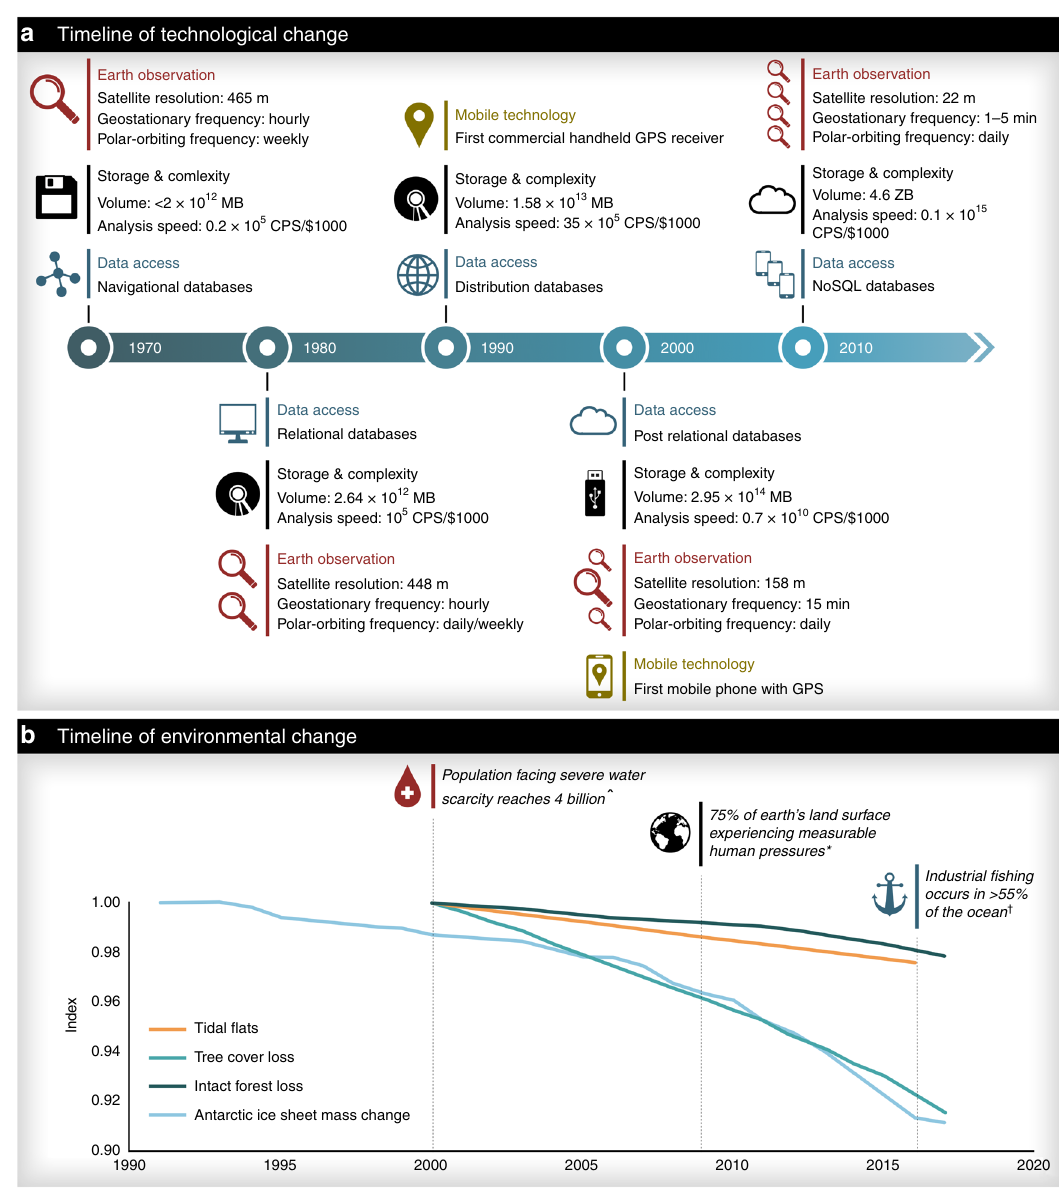
Fig. 1 Timeline of selected technological and environmental changes. ( a ) The volume of data produced has grown exponentially and is expected to soon reach 40 Zettabytes (40 trillion Gigabytes). Such data generation is only possible due to the concurrent growth in data storage and computing speed, which has moved from the fl oppy disk (~1 calculations per second per $1000) to cloud-based storage (>10 15 calculations) in last 30 years 1 . Despite this exponential growth in technological capacity, and increasing environmental applications, our planet is still facing serious environmental declines ( b ). All environmental declines shown are sourced from prior studies (as detailed below) and are indexed relative to their state in the fi rst year plotted (i.e., dividing by the fi rst value in each time series), with the exception of Antarctic ice sheet mass change 2 , which was indexed against expected (BAU) loss by 2100 (81 cm sea-level rise equivalent 3 ). Tidal fl ats represent the overall decline across the globe for time period, and does not show annual fl uctuations 4 . Intact Forest Landscapes and tree cover loss does not take into account gains 5,6 . Note the index on the y -axis is only shown for the range 0.9 – 1. Ɨ Data from Global fi shing watch 7 . *Based on the global human footprint 8 . ^For at least 1 month a year over the period 1996 – 2005 9